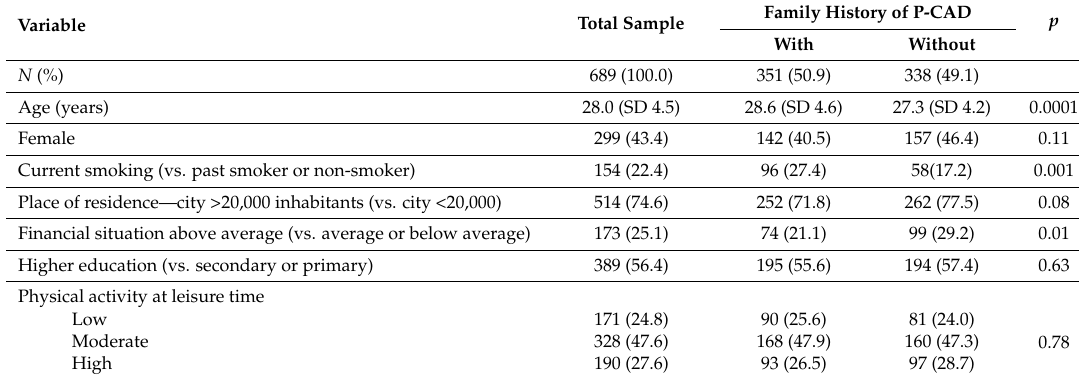
Table 2. Characteristics of the study sample.